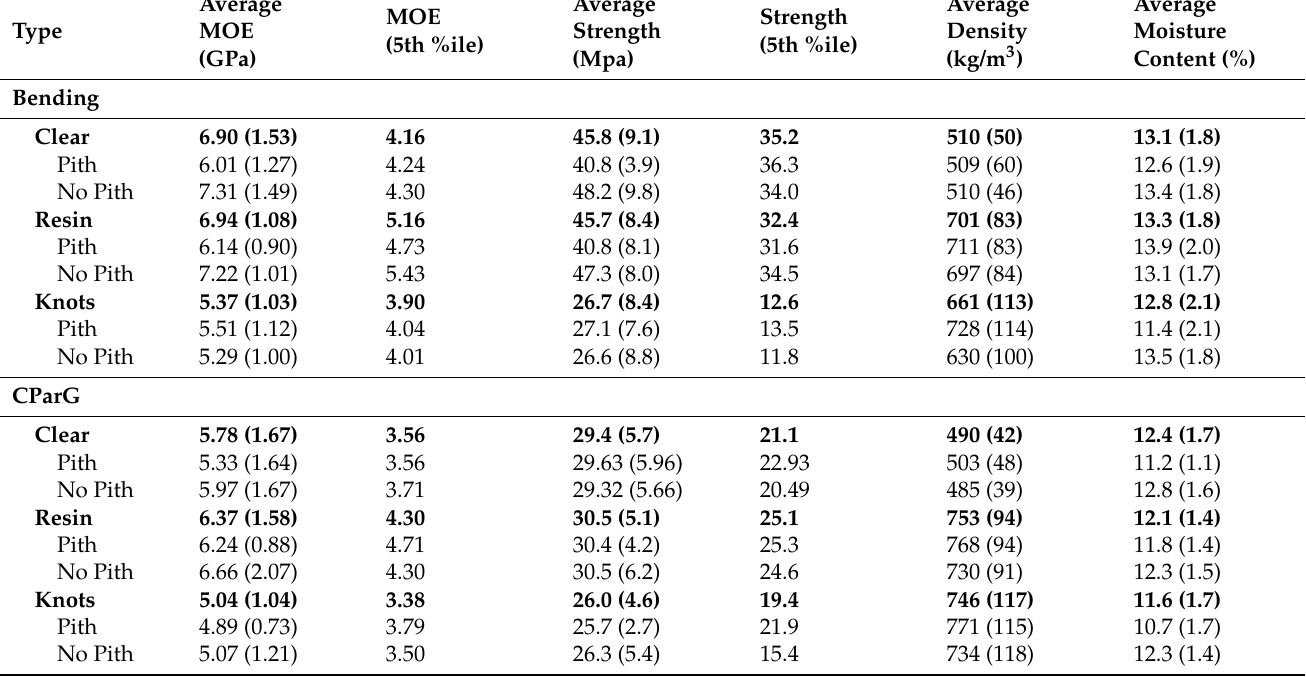
Table 2. Summary of test